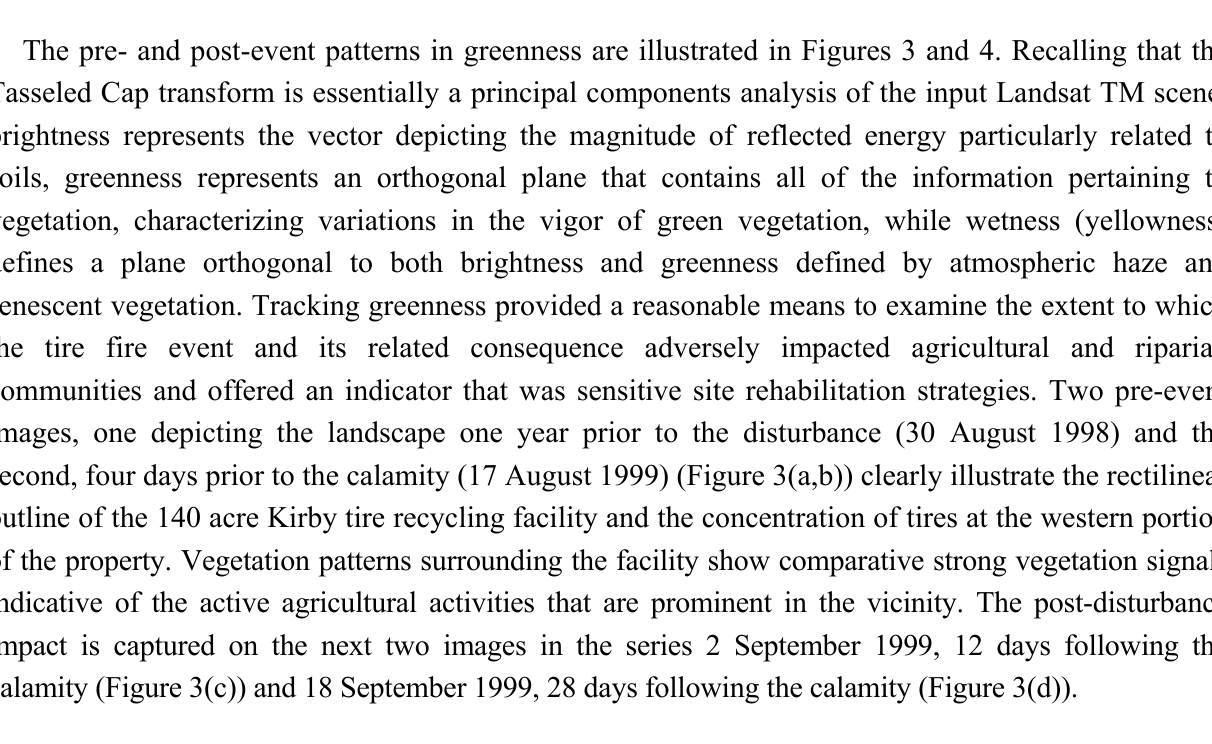
Figure 3. Greenness index characterization time sequence pre and immediate post